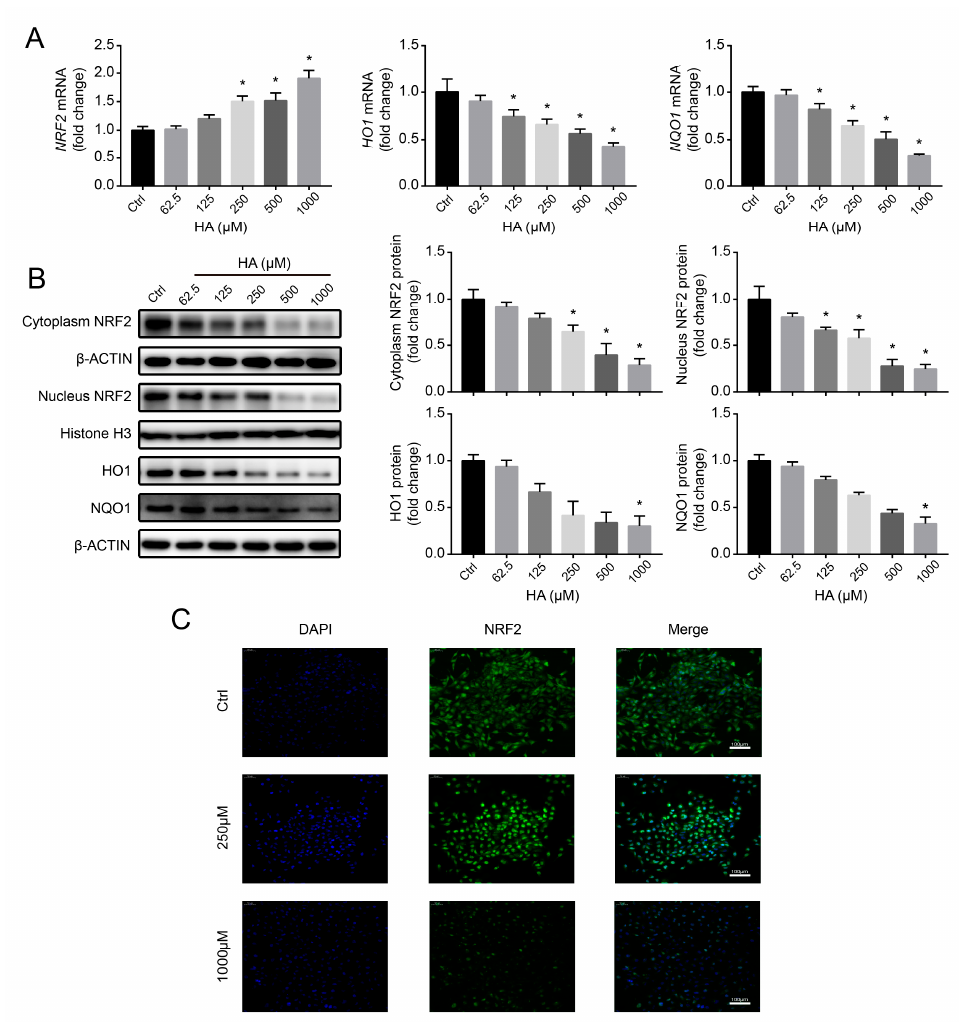
Figure 4. Effects of HA on the nuclear factor erythroid 2-related factor 2 (NRF2)-mediated antioxidant system in HK-2 cells. ( A ) Levels of mRNA expression of NRF2 , heme oxygenase-1 ( HO1 ), and NAD(P)H quinone dehydrogenase ( NQO1 ) after treatment with 0–1000 µM HA. ( B ) Levels of protein expression of cytoplasmic and nuclear NRF2, HO1, and NQO1 after treatment with 0–1000 µM HA. Quantification was performed by densitometry. ( C ) Immunofluorescence staining for NRF2 (green) after treatment with 250 and 1000 µM HA. Nuclei (blue) were stained with DAPI. Bar = 100 µm. Data are presented as the mean ± standard deviation. * p < 0.05 vs. control (Ctrl) cells. Experiments were repeated three to four times.